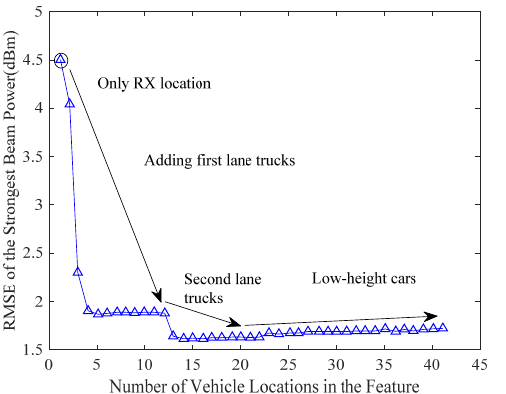
Figure 7. Comparison of alignments with different degrees of situational